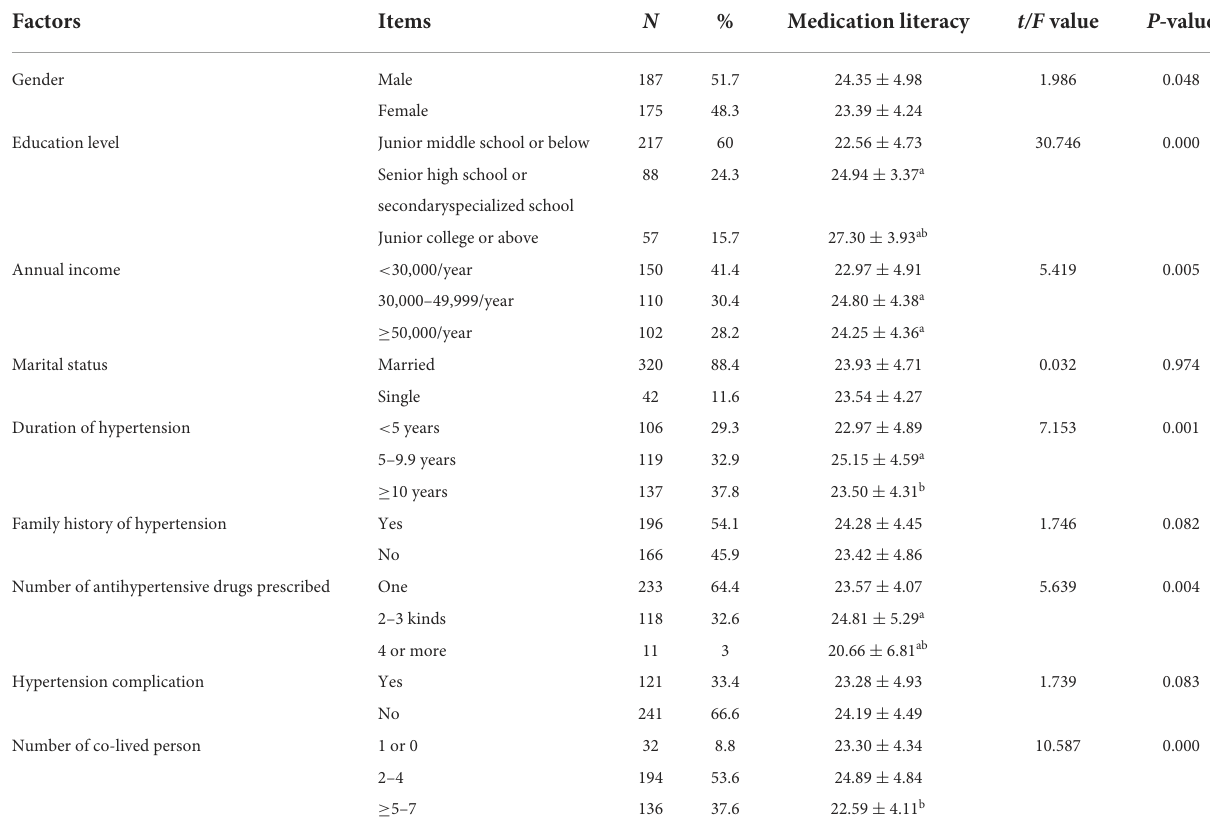
TABLE 1 Patient characteristics ( n =